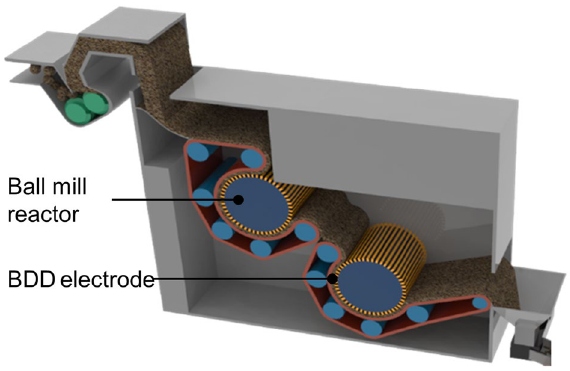
Figure 6. Schematic of the CD equipment. It uses a BDD electrode instead of an IrO 2 electrode.